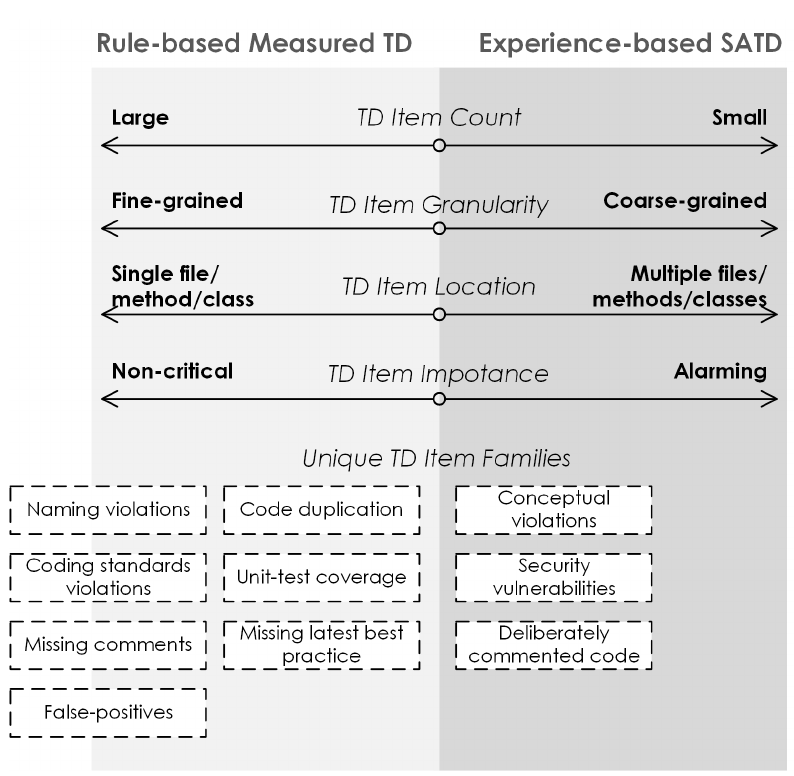
Figure 3. Identified causes for mismatch—a graphical